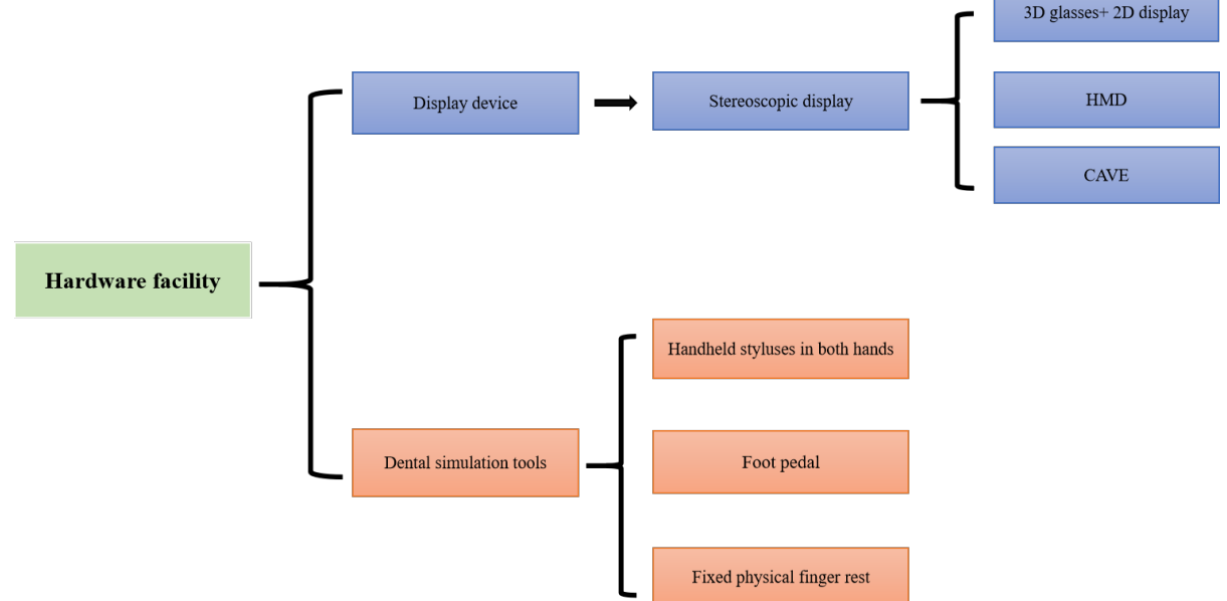
Figure 4. Hardware facilities required for a dental simulator. CAVE: Cave Automatic Virtual Environment; HMD: head-mounted